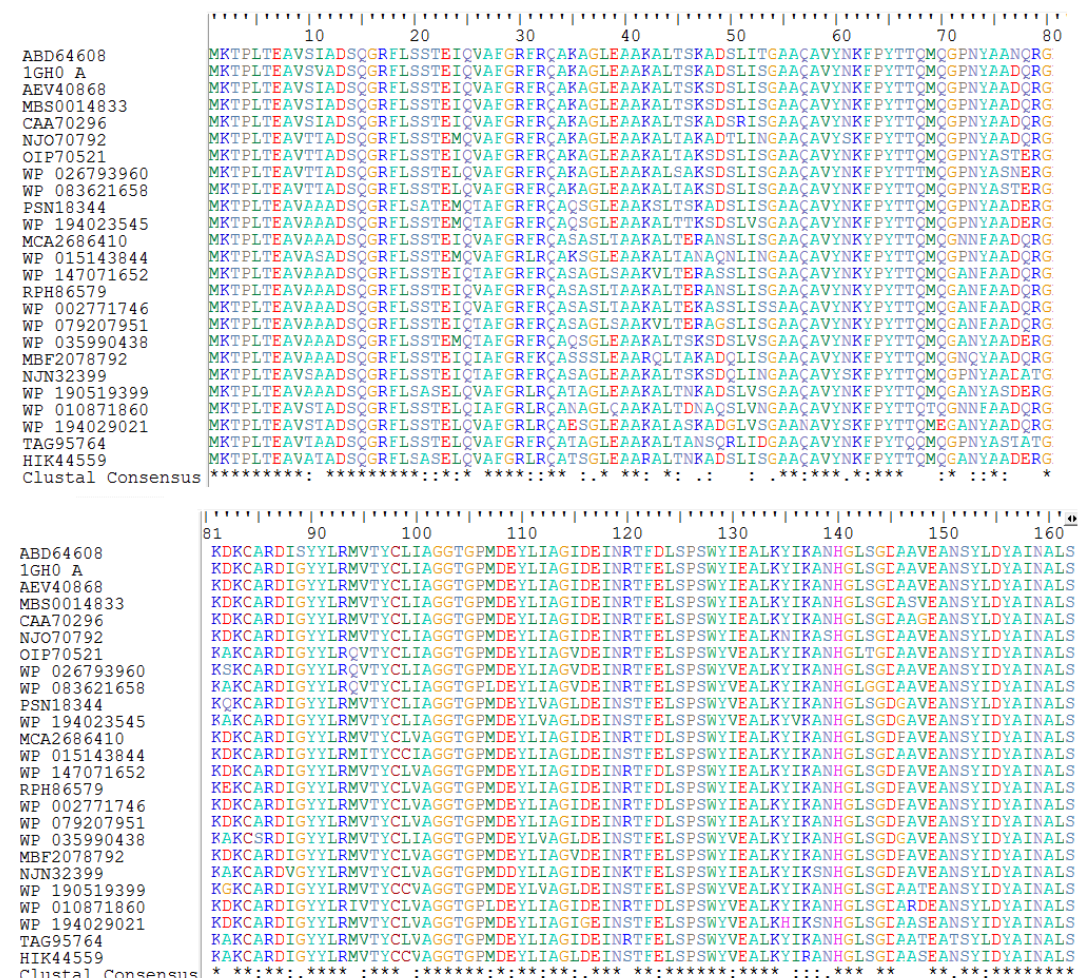
Figure 7. Multiple alignment of amino acid sequences of phycocyanin subunit alpha of 25 cyanobacterial species, including A. platensis strains and variants, using BioEdit. Amino acids are shown